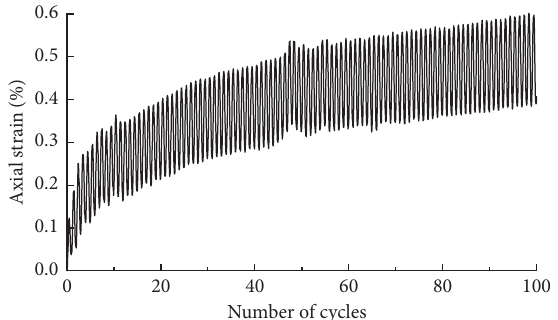
Figure 5: Axial strain versus number of cycles under bias sine wave